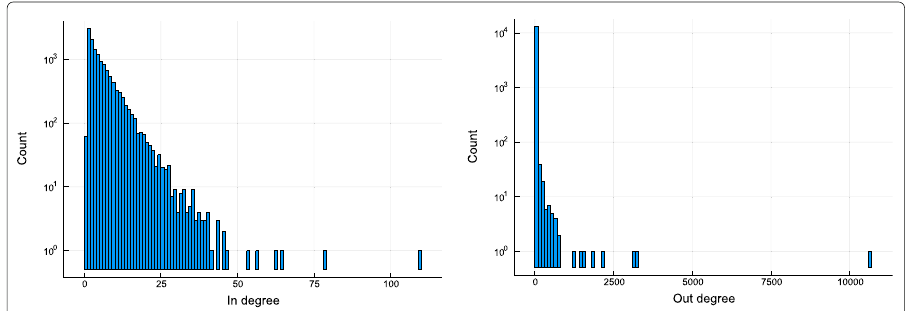
Fig. 6 CRAN degree distributions. In and out degree distributions for the CRAN package ecosystem